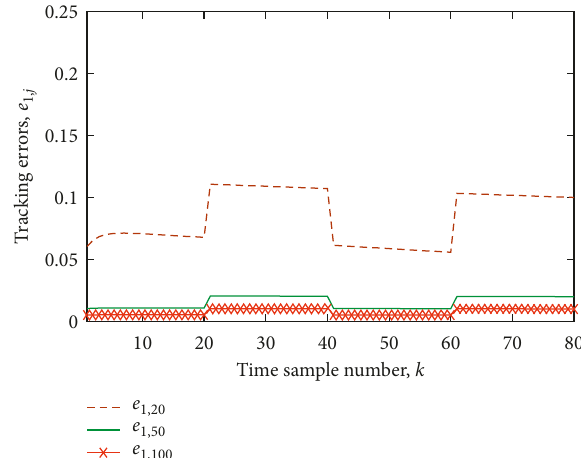
Figure 10: Output y 2 at the 20th, 50th, and 100th iterations.